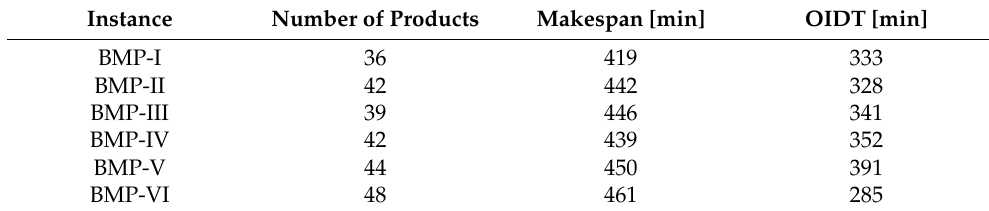
Table 3. The actual state of the efficiency of the production schedules, collected from the bakery.